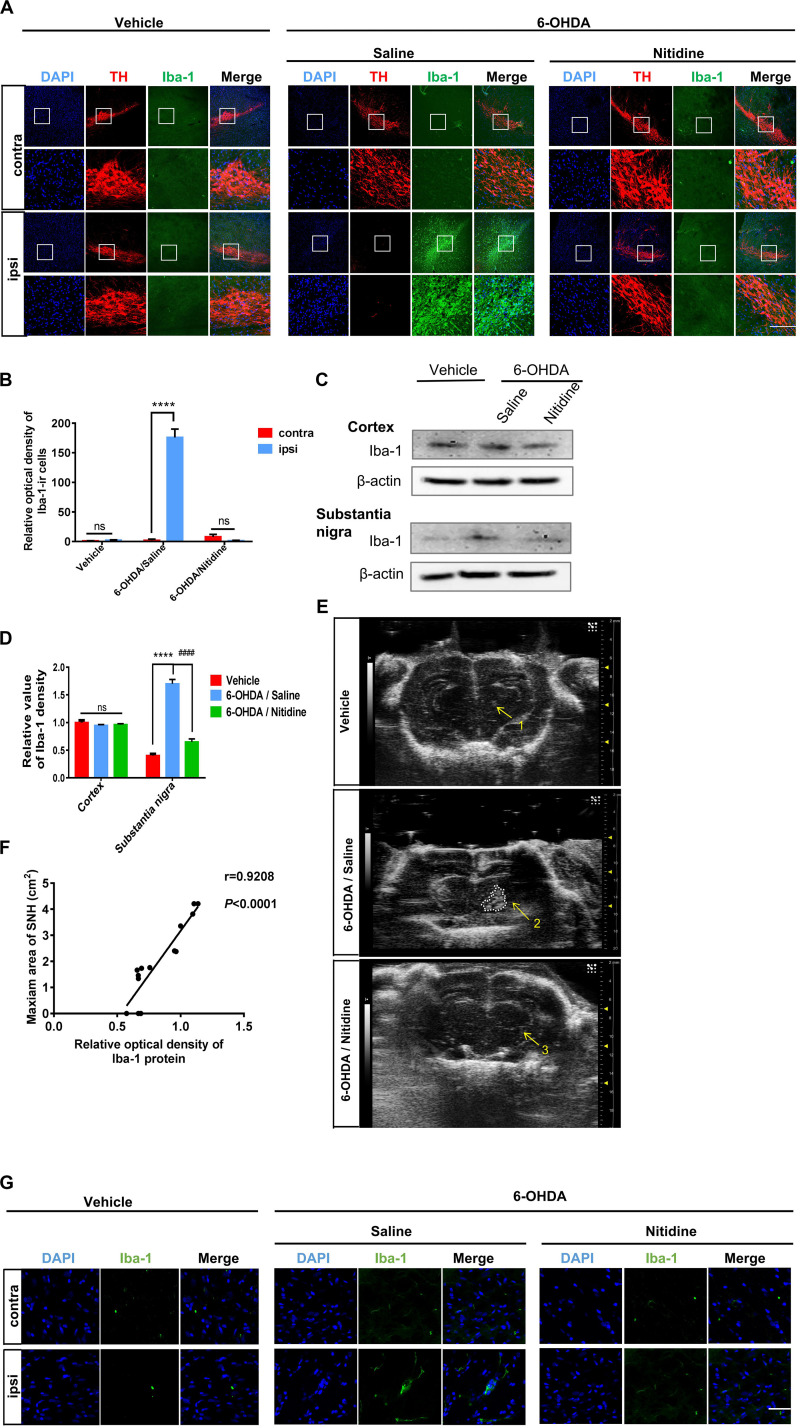
Reactive microgliosis in the substantia nigra (SN) of 6-hydroxydopamine (6-OHDA)-induced Parkinson’s disease rats with or without nitidine treatment. (A) Double immunofluorescence of the activated microglia marker Iba-1 (green) and tyrosine hydroxylase-immunoreactive dopaminergic neurons (red). Scale bar depicts 500 μm. (B) Statistical result of the optical density values of Iba-1-ir cells. Vehicle group: t-test. P = 0.0589, t = 2.618 df = 4, F = 4.355. 6-OHDA/saline group: t-test. P < 0.0001, t = 20.99, df = 4, F = 52.36. 6-OHDA/nitidine: t-test. P = 0.0554, t = 2.678, df = 4, F = 86.41. (C) Iba-1 protein expression revealed by Western blot. (D) Histogram showing that the level of Iba-1 protein was significantly decreased in the SN of the nitidine-treated group. One-way ANOVA. Cortex: P = 0.4348, F = 0.96. Substantia nigra: P < 0.0001, F = 141.8. (E) Transcranial sonography (TCS) images and substantia nigra hyperechogenicity (SNH) qualification after nitidine or saline treatment. Only a scatter echo matching the shape of the needle emerged in the vehicle group (1); the nitidine-treated group did not show visible SNH (3), while the saline-treated group showed a significant SNH (2). Area 2 = 1.111 cm2. (F) Correlation analysis between Iba-1 protein expression and maximum SNH area under TCS. P < 0.0001, r = 0.9208, R2 = 0.848, F = 66.93. (G) Morphological changes of Iba-1-ir microglia under × 80 lens. Scale bar depicts 3 cm. *Comparison between contralateral and ipsilateral from a single group. #Comparison between different groups. ns P > 0.05, #P < 0.05, ####P < 0.0001, **P < 0.01, ***P < 0.001, ****P < 0.0001.